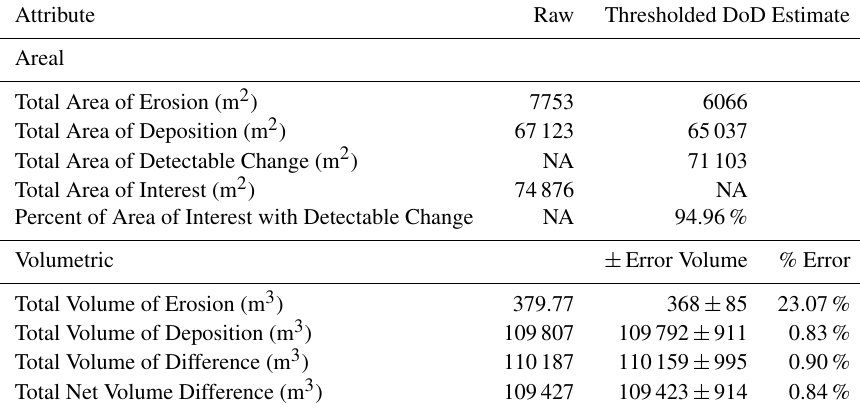
Table 2. Summary of DoD analysis.